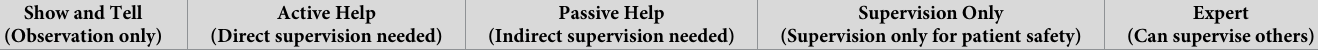
Table 2. Modified self-reported Zwisch rating scale for core clinical skills related to substance use disorders. Show and Tell (Observation